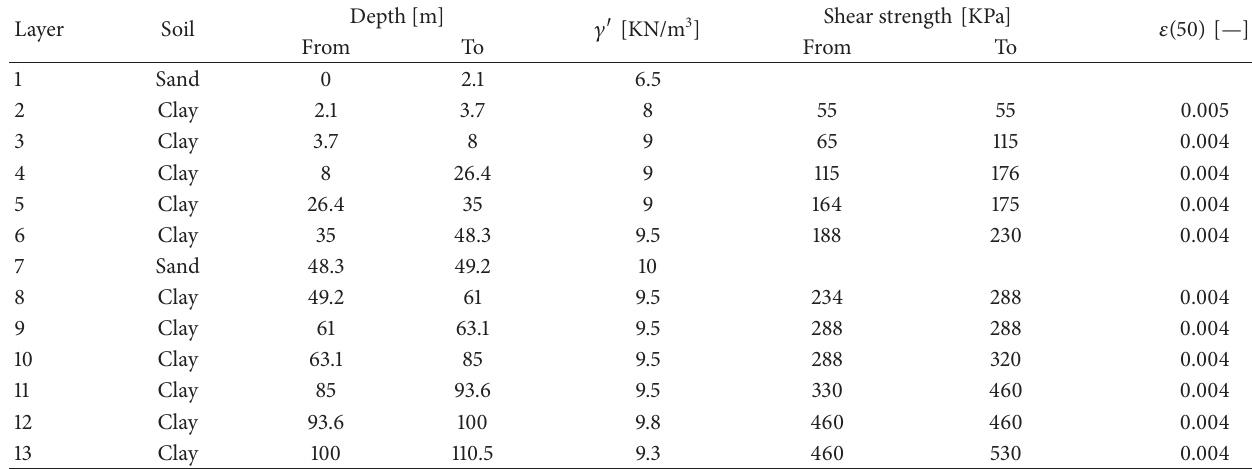
Table 2: Design soil parameters for dynamic